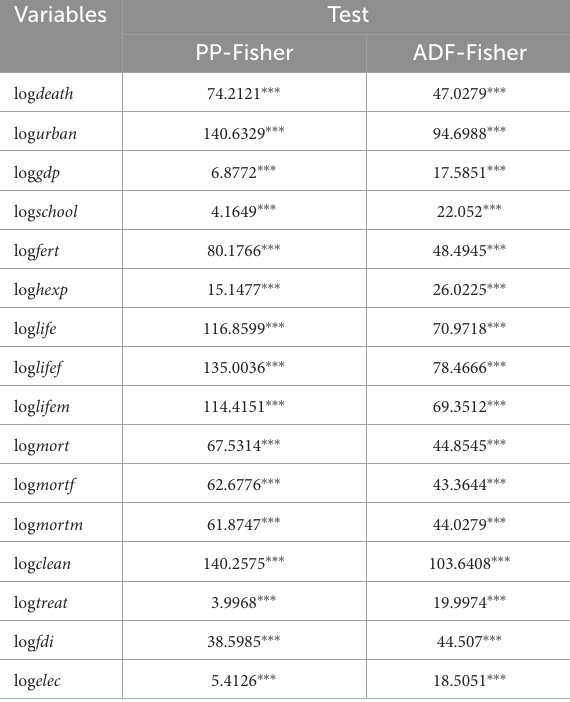
TABLE 4 Two-way fixed effect estimation